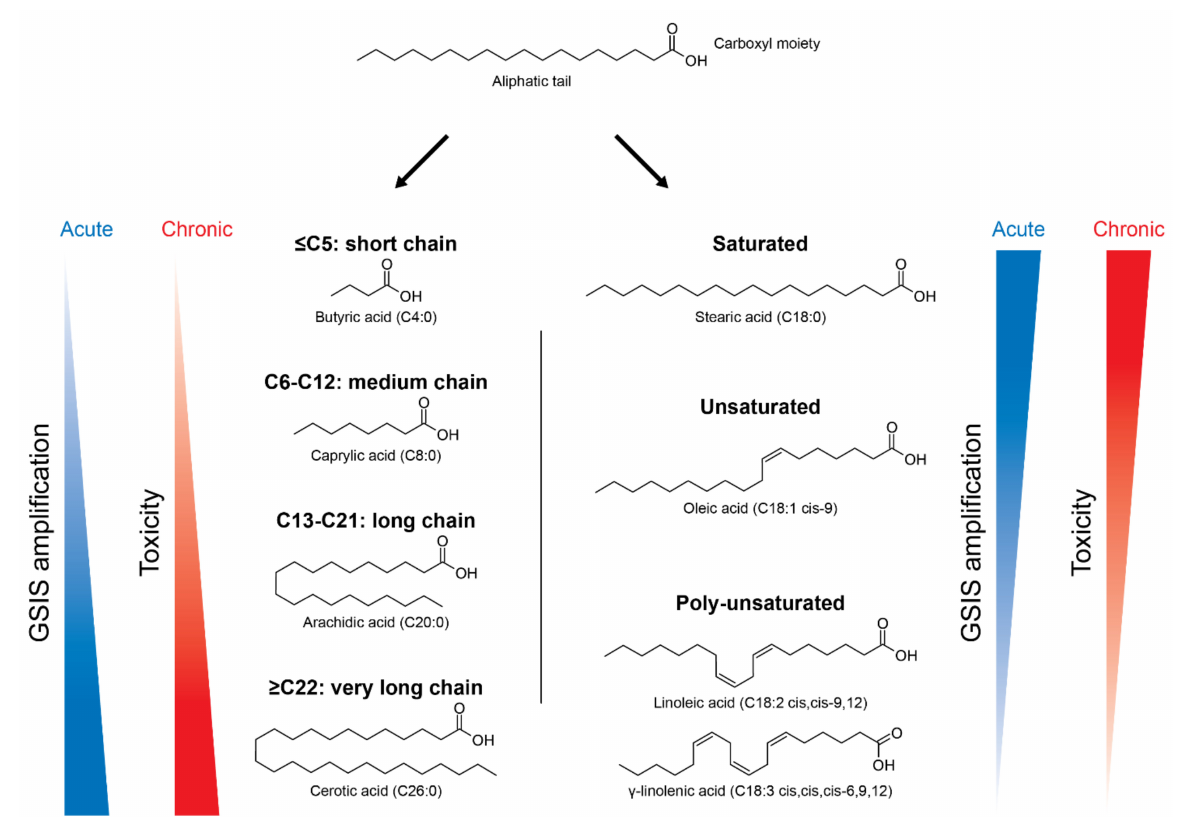
Figure 1. Nomenclature of different types of fatty acids (FAs) and their effects in pancreatic β -cells according to chain length and degree of saturation. FAs are composed by a carboxyl moiety bonded to an aliphatic tail, with variable number of carbons. Depending on the number of carbons, FAs can be divided in short-chain (C ≤ 5), medium-chain (C6-C12), long-chain (C13-C21) and very long-chain (C ≥ 22). They can also be: (i) saturated, with no double bonds, as stearic acid (C18:0); (ii) unsaturated, with one double bond, as oleic acid (C18:1); and (iii) poly-unsaturated, with more than two double bonds, as linoleic acid (C18:2) and γ -linolenic acid (C18:3). FAs are known to increase the glucose-stimulated insulin secretion (GSIS), but can also be toxic in the long-term. The potency of GSIS amplification is positively influenced by the carbon chain length and negatively influenced by the degree of